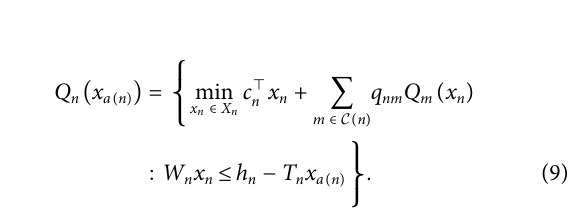
FIGURE 8 | Optimal solutions of the stochastic process network design problem corresponding to nodes n 2 , ... , n 7 . The material fl ow rates at each node are shown in red. The installed capacities are shown in blue italics.